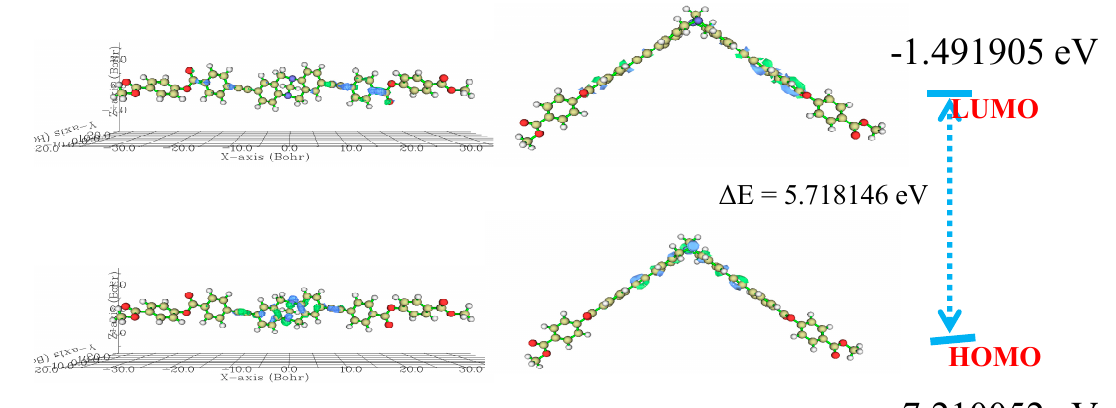
Figure 3. HOMO/LUMO imagines of 8 calculated by Gaussian 09 program using the B3LYP method with the 6-31G + (d,p) basis set [51].